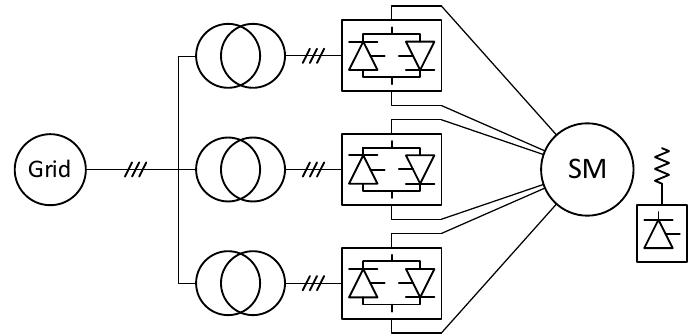
Figure 8. Block diagram of the cycloconverter drive.